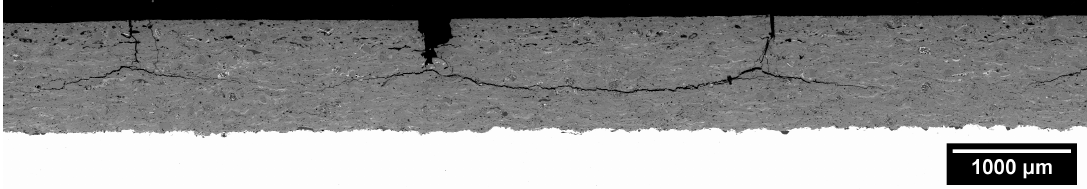
Figure 6. Cross-section of plasma surface heat treated sample P2 containing a major vertical and horizontal cracks, classified as type 3 in this paper. Such cracking yields the procedure unusable for applications.